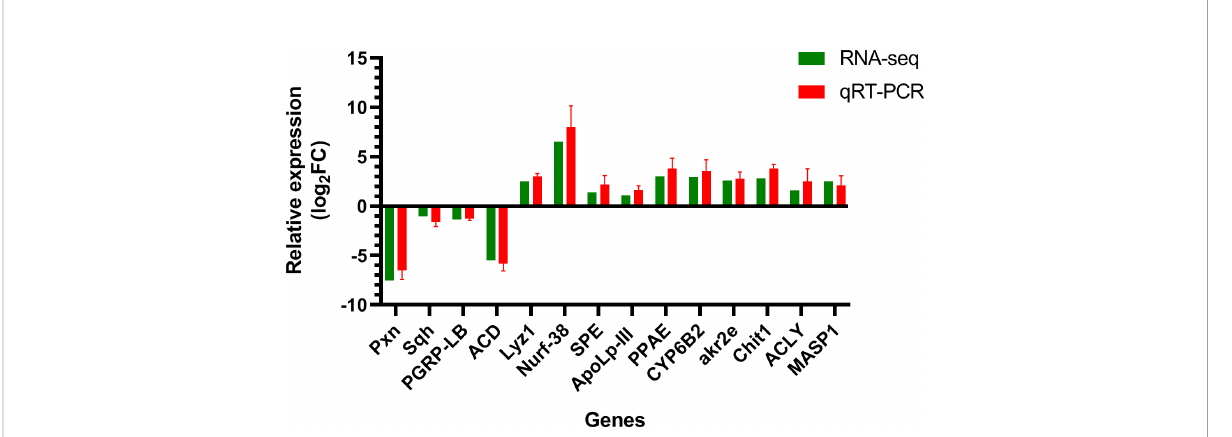
FIGURE 8 Validation results of RNA-seq pro fi les by real-time PCR. The y-axis indicates the value of relative expression level (2 - DD Ct ) by qRT-PCR and log 2 ratio of PS/control RNA-seq. Pxn, peroxidasin isoform X2; Sqh, myosin light polypeptide 9 isoform X1; Lyz1, putative lysozyme; Nurf-38, inorganic pyrophosphatase; SPE, serine protease easter-like; ApoLp-III, apolipophorin-III precursor; PPAE, prophenoloxidase activating enzyme precursor; CYP6B2, cytochrome P450; PGRP-LB, peptidoglycan-recognition protein LB-like; akr2e, aldo-keto reductase AKR2E4-like; Chit1, Glycosyl hydrolases family 18; ACLY, ATP-citrate synthase-like; MASP1, serine protease gd-like; ACD, acyl-CoA desaturase-like; GAPDH, glyceraldehyde-3-phosphate